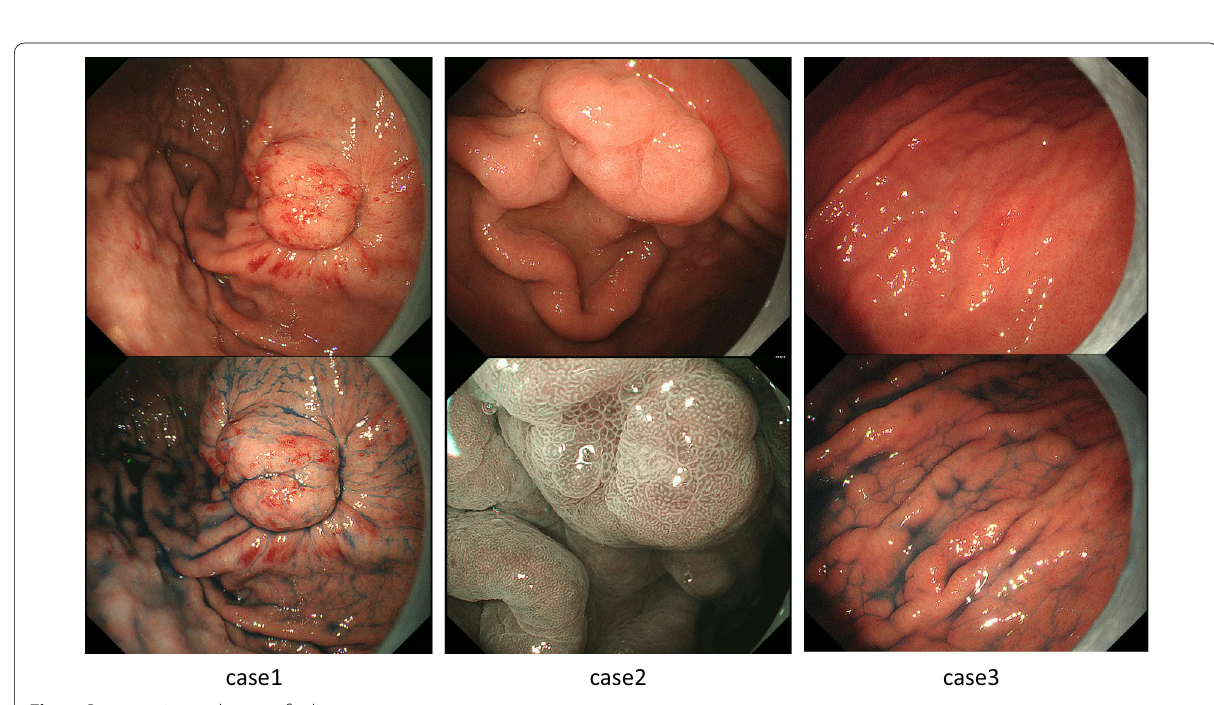
Fig. 1 Preoperative endoscopy